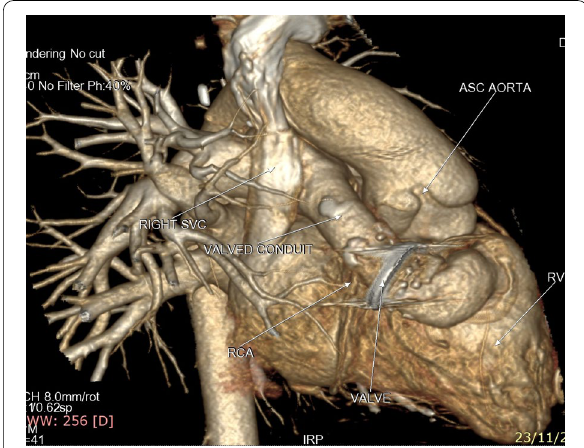
Fig. 8 3D volume rendering image showing valved conduit from the right ventricle to the main pulmonary artery with mild calcification